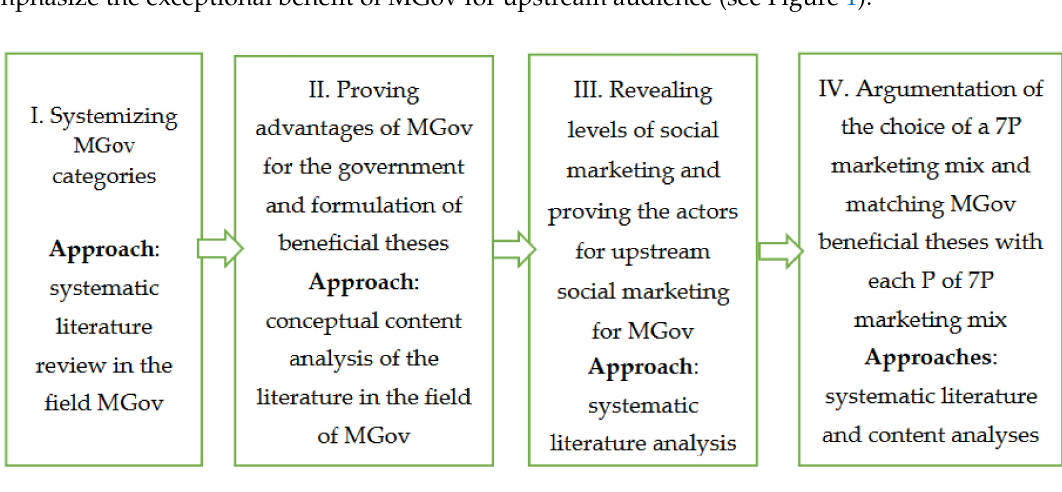
Figure 1. Research